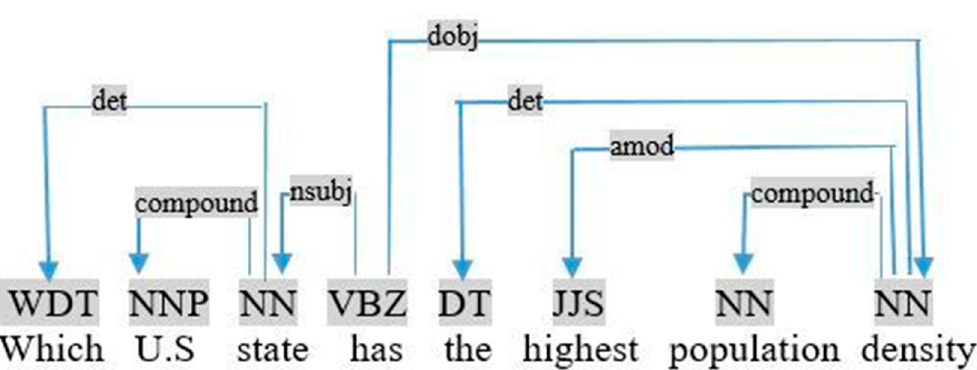
Figure 15. Graph dependency of the query «which U.S. state has the highest population density».